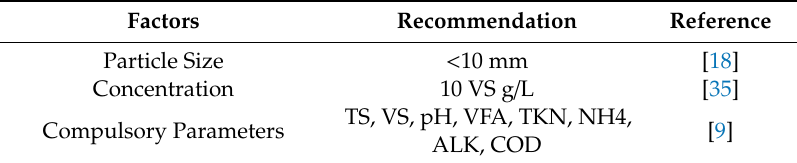
Table 2. Recommended substrate conditions for BMP